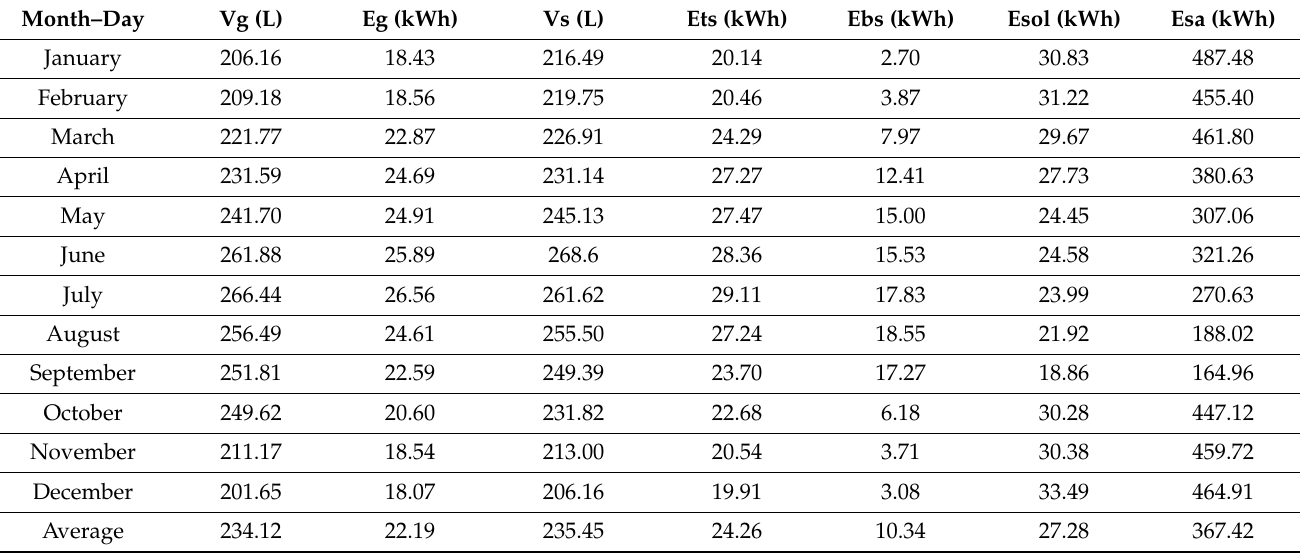
Table 3. Average month–day performance of electric geyser and solar water heater performance.